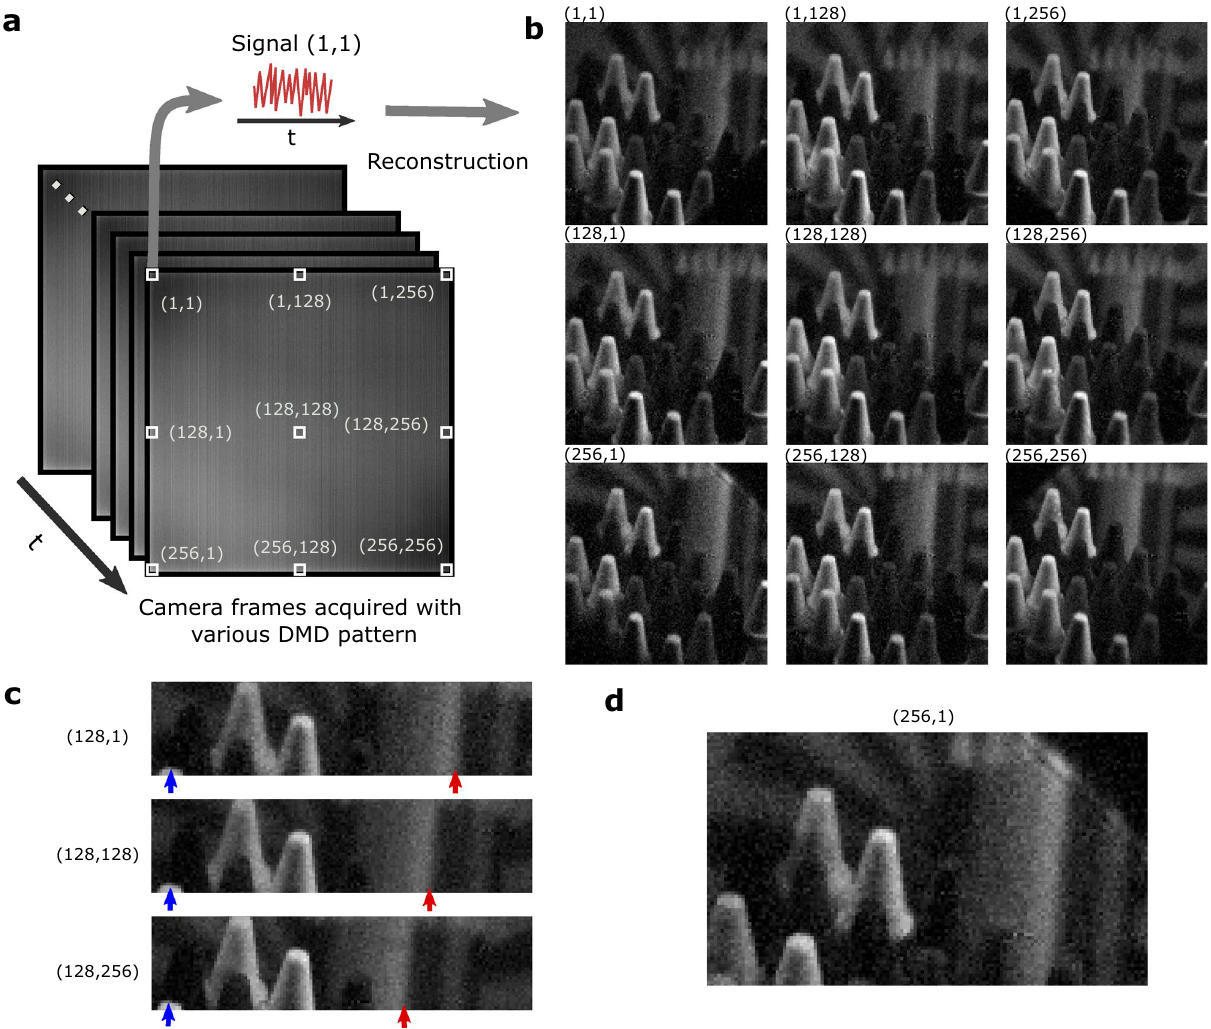
Figure 2. A computational light-field acquisition. ( a ) Schematic principle of the reconstruction. The set of camera frames acquired with different patterns are used to extract signals. A single signal is obtained by selecting in each of the images a particular 4 × 4 -binned pixel. With each of the 256 × 256 obtained signals one can reconstruct an image of the scene as seen from a particular POV through a single pixel camera reconstruction. ( b ) Nine of the 256 × 256 reconstructed images obtained for a single light-field acquisition. These images correspond to a reconstruction of the same scene from different points of view, obtained by using camera binned-pixels with coordinate ( x , y ). ( c ) Detail extracted from three reconstructed images. The red and blue arrows highlight the position of two features in the different images. ( d ) Detail showing a vignetting effect observable on the images reconstructed using the four pixels in the corner of the CCD